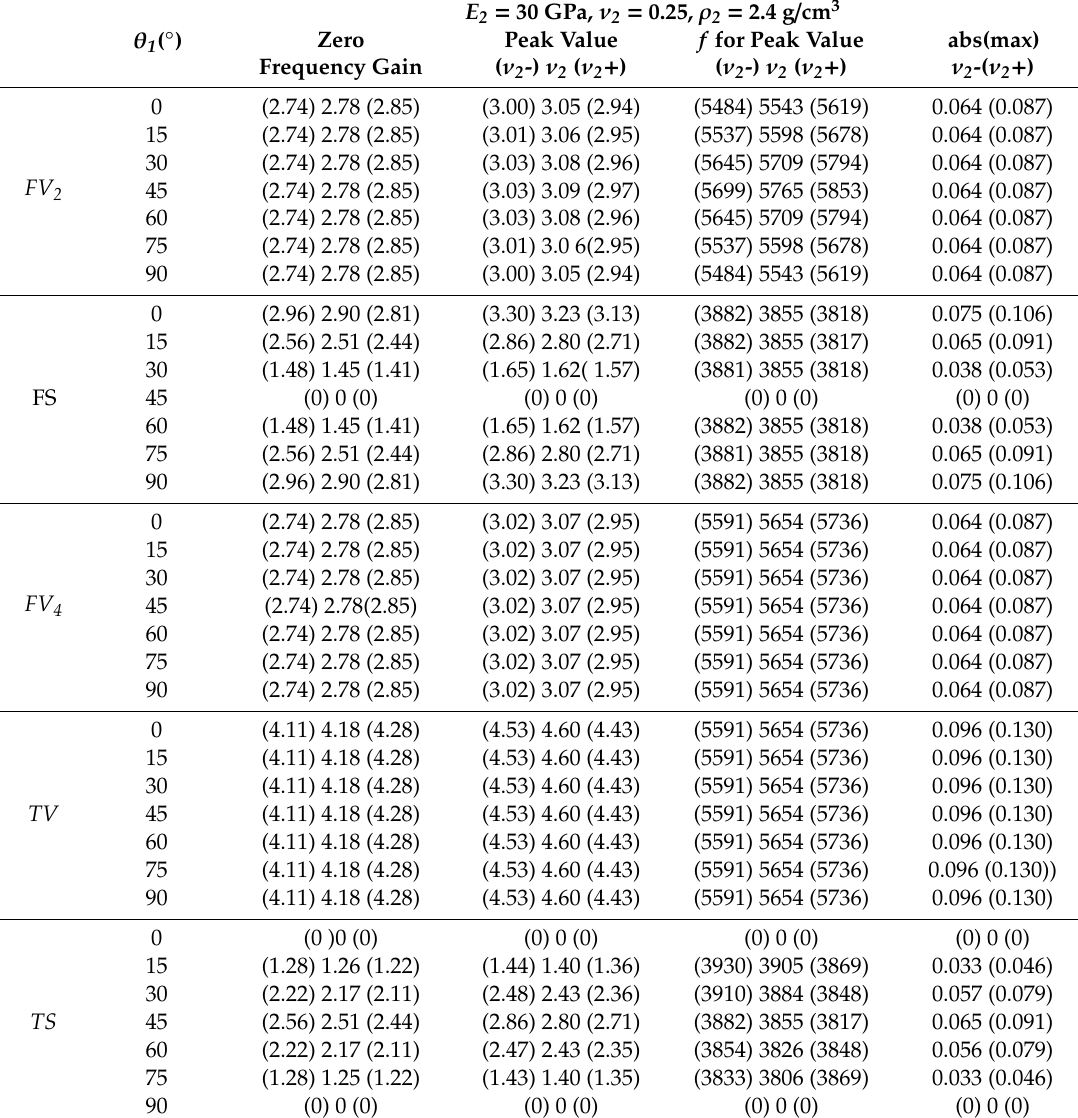
Table 3. Influence of Poisson’s ratio of the expansive grout on the theoretical amplitude spectrum of gauge combinations FV 2 , FV 4 , FS, TV and TS for the incident P